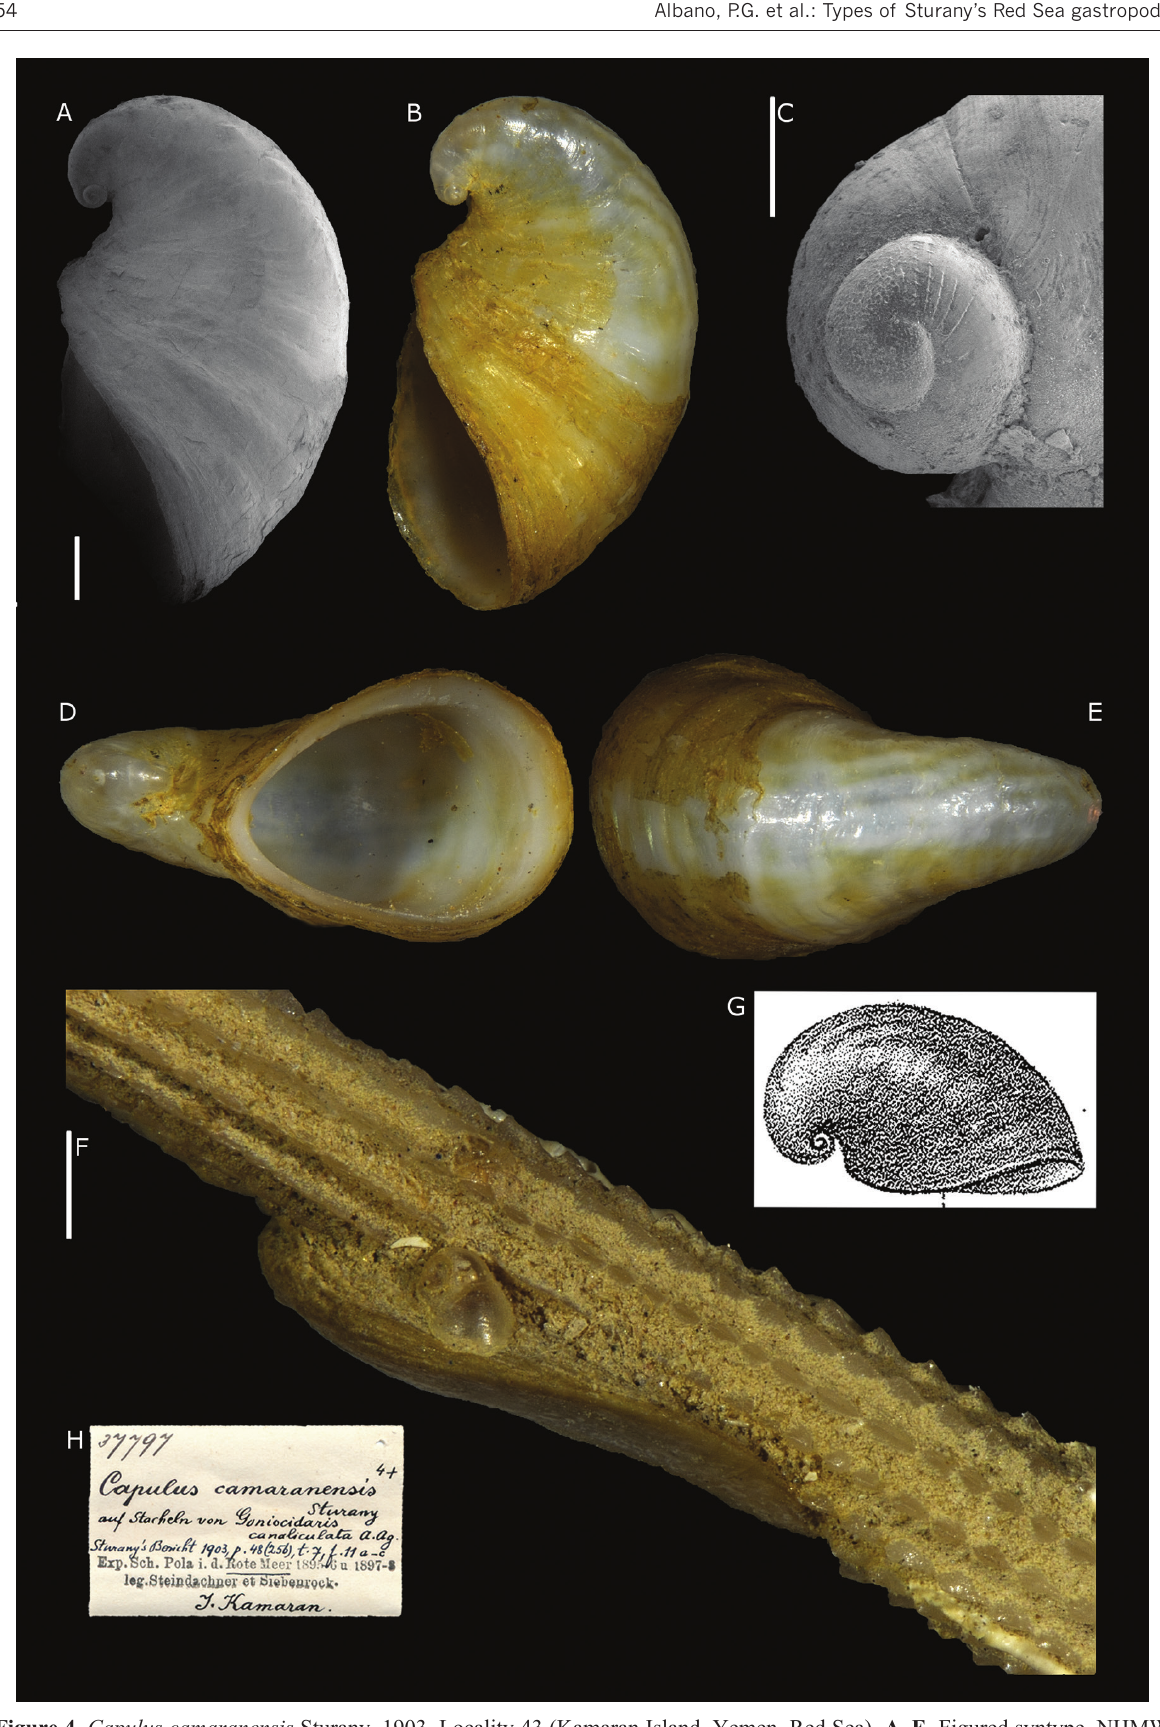
Figure 4. Capulus camaranensis Sturany, 1903, Locality 43 (Kamaran Island, Yemen, Red Sea). A–E . Figured syntype, NHMW 37797: left side ( A–B ), protoconch ( C ), aperture ( D ), top ( E ). F . Post-metamorphic stage attached to Goniocidaris canaliculata (A. Agassiz, 1863). G . Original figure by Sturany (1903). H . Original label. Scale bars: A–B, D–F : 1 mm, C : 0.2